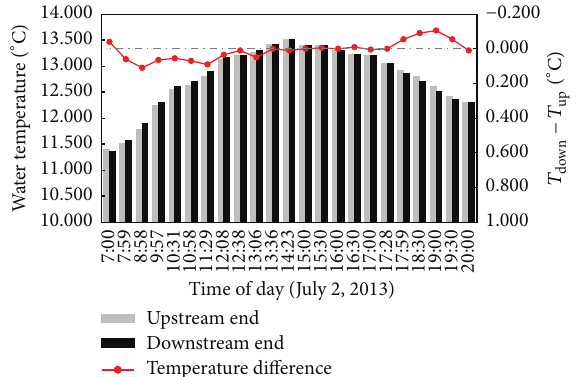
Figure 9: Diurnal variations of the evaporation rate of four days (2013).